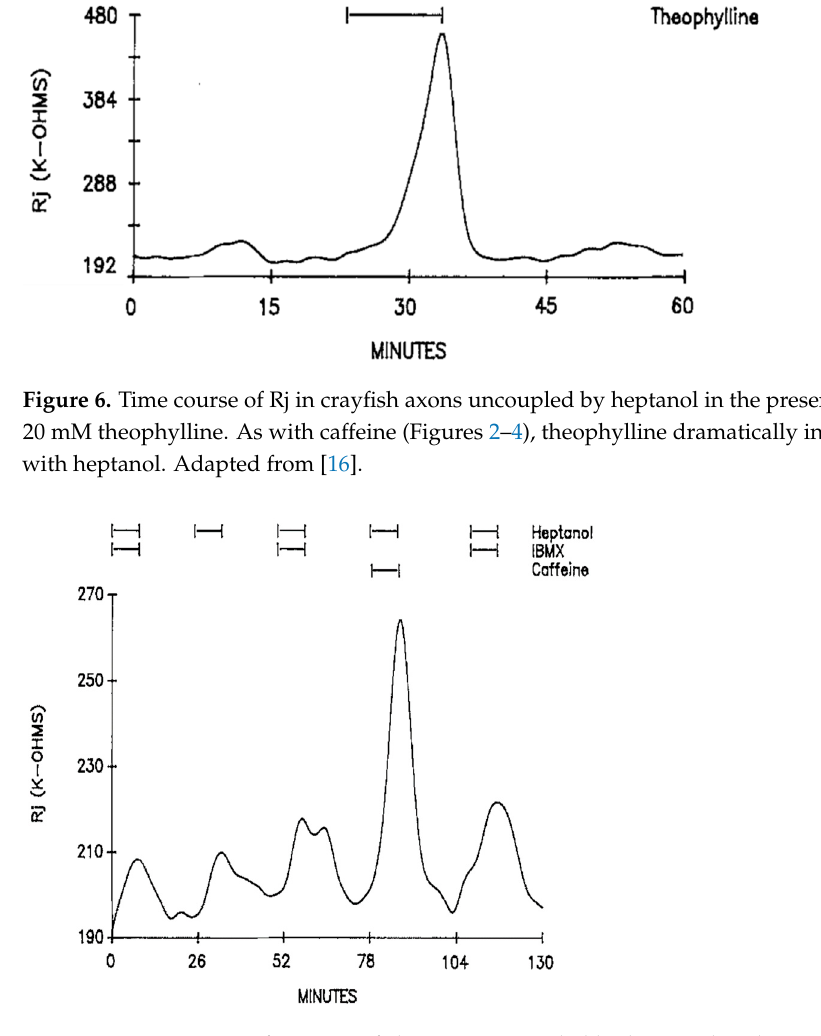
Figure 8. Time course of Rj in crayfish axons uncoupled by heptanol ( A ) or acetate ( B ) in the pres- ence or absence of 5 mM 4-aminopyridine (4-AP). 4-AP dramatically reduce the Rj maximum with heptanol ( A ). In contrast, addition of 4-AP to acetate solutions (Ac) does not affect the acetate-un- coupling efficiency ( B ). Adapted from [16].